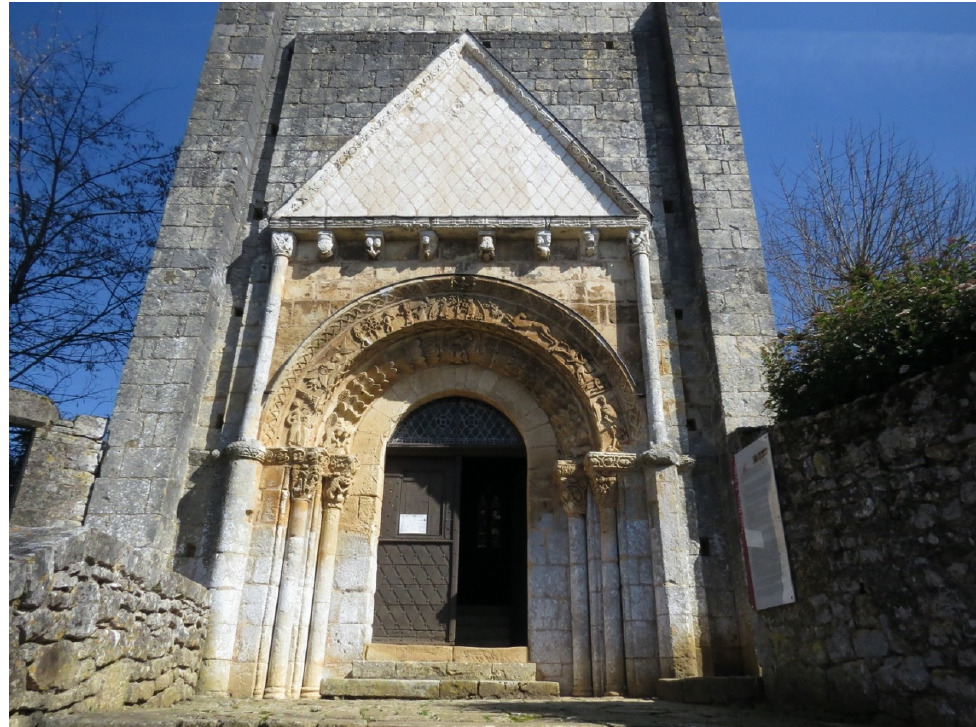
Figure 15. Saint-Martin Church , west façade, 12th c., Besse, Dordogne, Nouvelle-Aquitaine, France. ©Author.